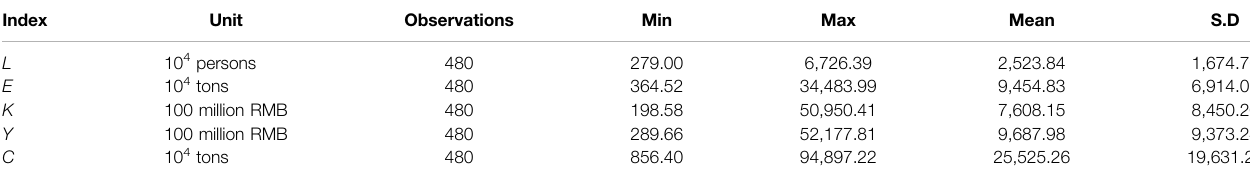
TABLE 1 | Summary statistics of inputs and